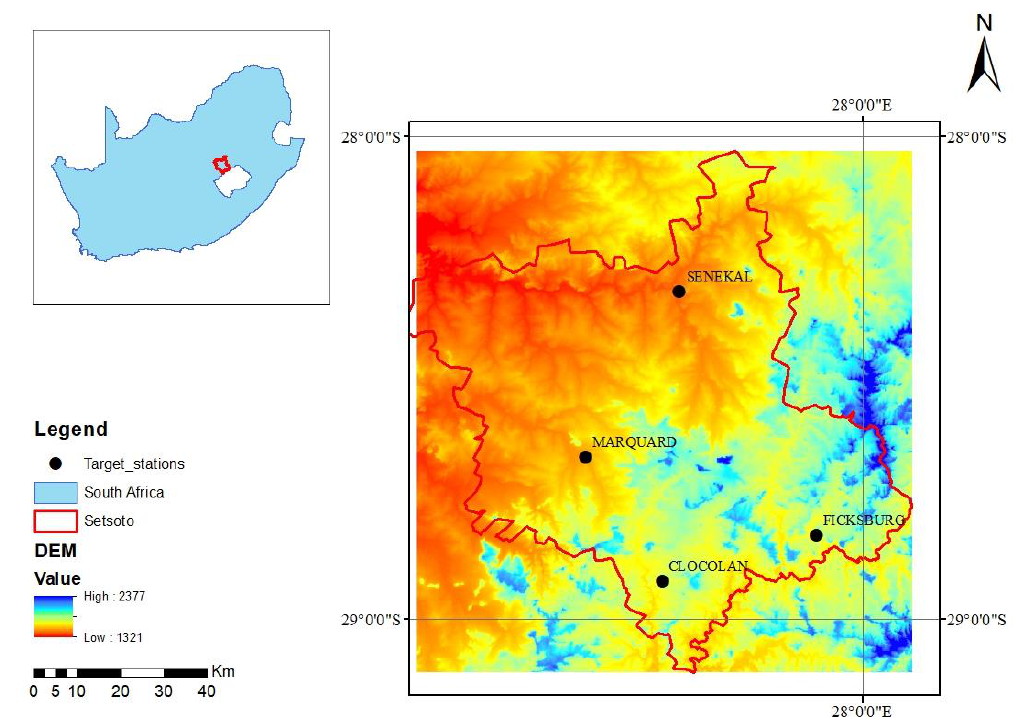
Figure 1. The study area and spatial distribution of the four weather stations in the Setsoto municipality of the Free State province of South Africa.